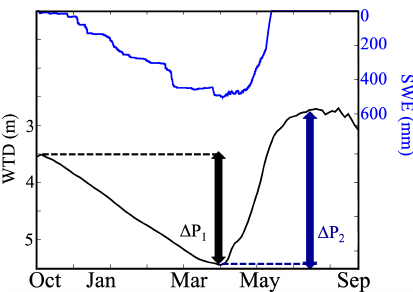
Figure 2. Temporal variations of water table depth (WTD) and SWE at an example hillslope. The location of the hillslope is shown in Fig. 1.